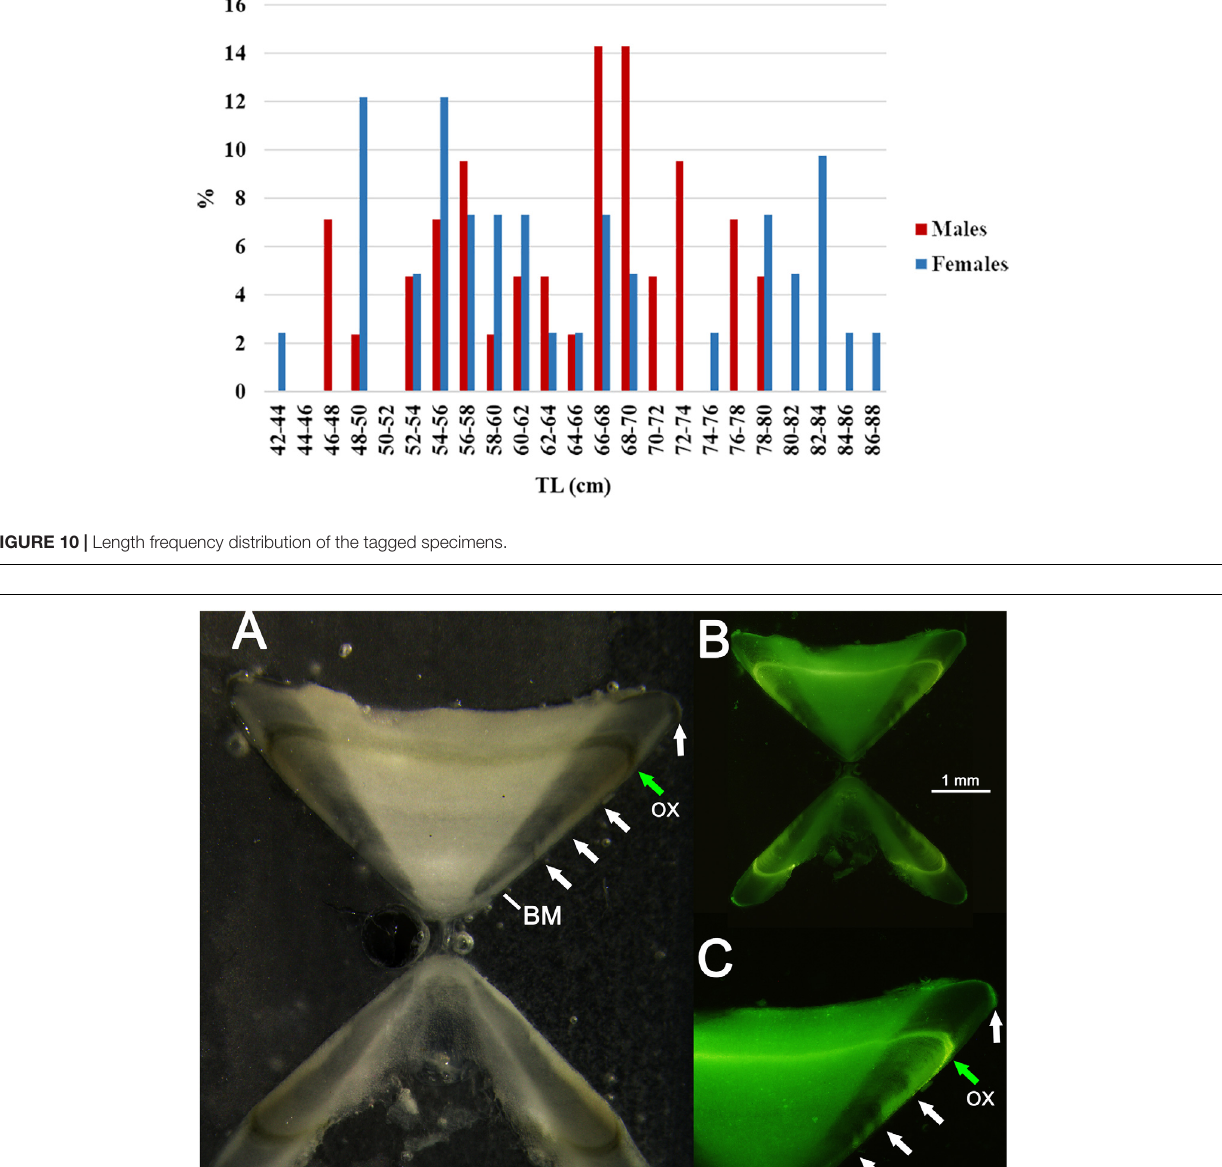
The TL of the tagged specimens ranged between 43.4 and 86.7 cm ( Figure 10 ). Two specimens were recaptured after 11 (cod. 1 captured ( Figure 9 ), having spent 328 and 417 days of freedom, respectively. The distances between the release and recapture